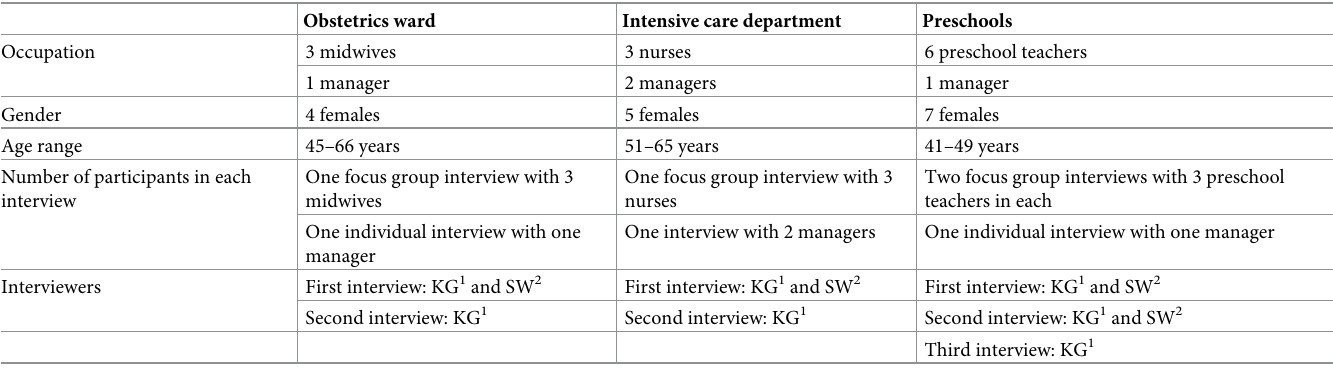
Table 1. Information regarding participants and focus